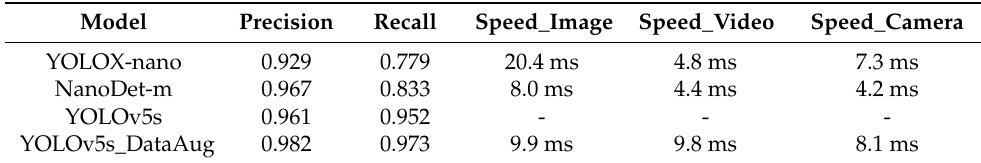
Table 1. Evaluation indices of different algorithms for sow posture and piglet object detection.